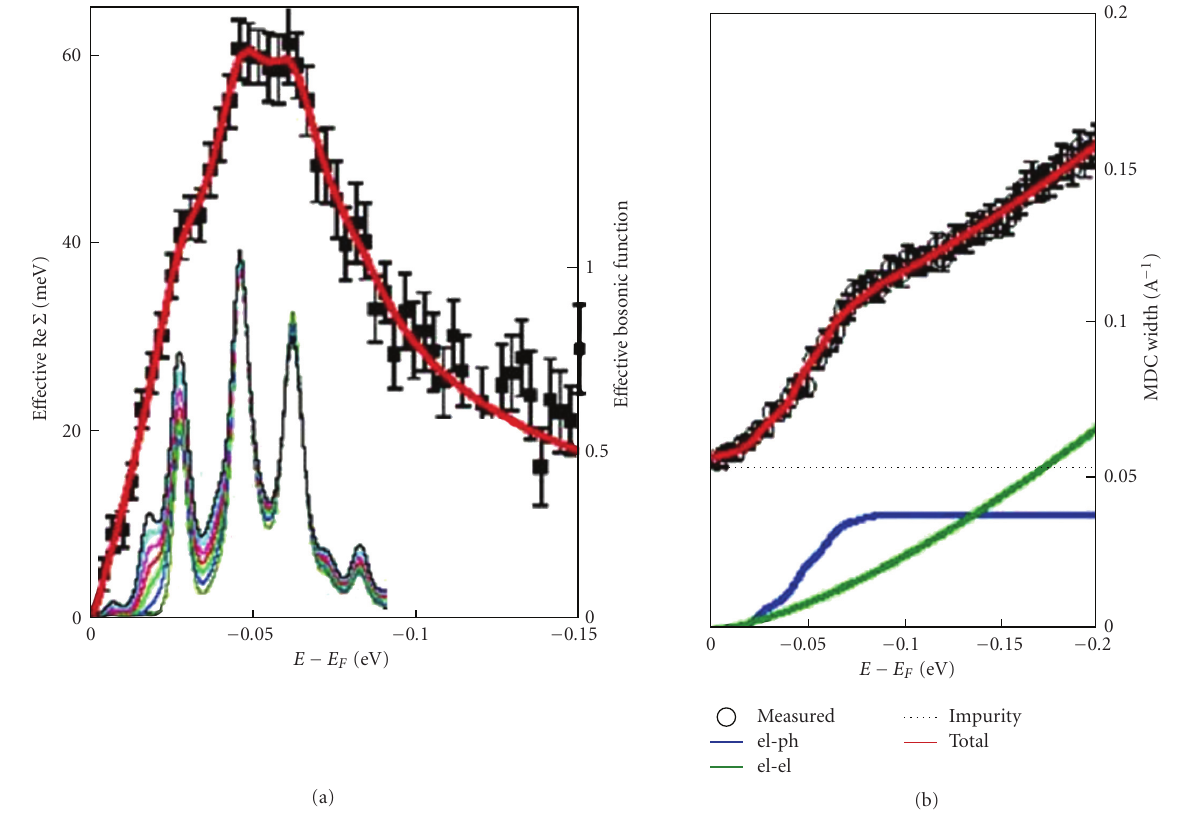
Figure 15: (a) E ff ective real self-energy for the nonsuperconducting La 2 − x Sr x CuO 4 , x = 0 . 03. Extracted α 2 the total MDC width—open circles. Bottom: the EPI contribution shows saturation, impurity contribution—dotted black line. The residual part is growing ∼ ω 1 . 3 . From